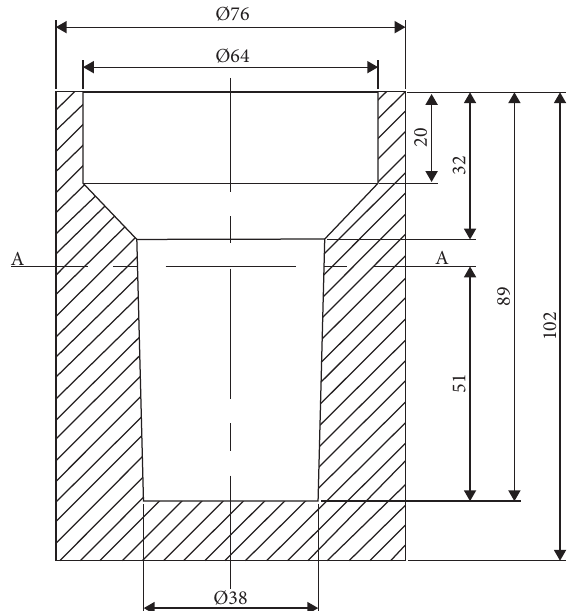
Figure 3: Reynolds standard golf T-mould